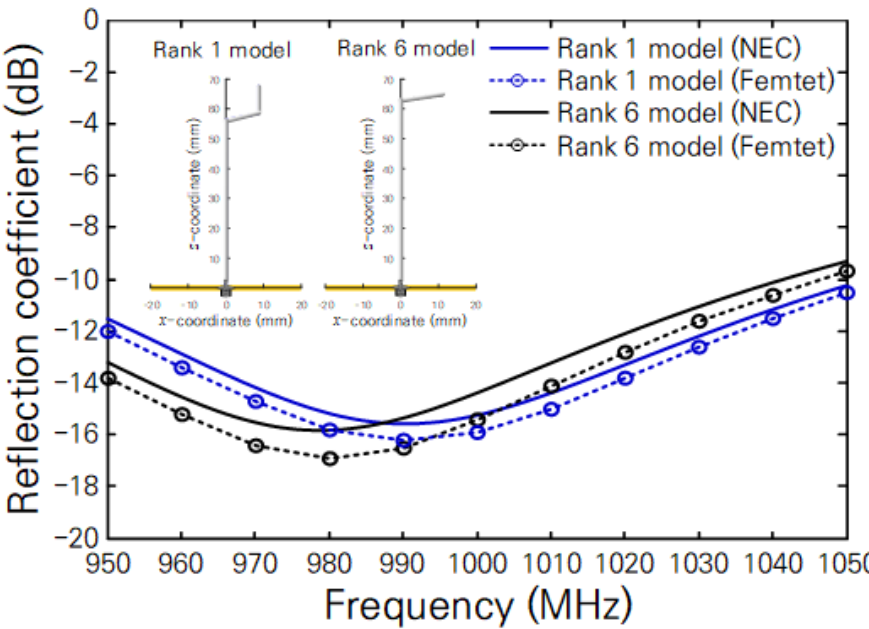
Figure 5. Impedance matching characteristics of the antennas with ranks 1 and 6 in Table 6. Appl. Sci. 2021 , 11 , 10829